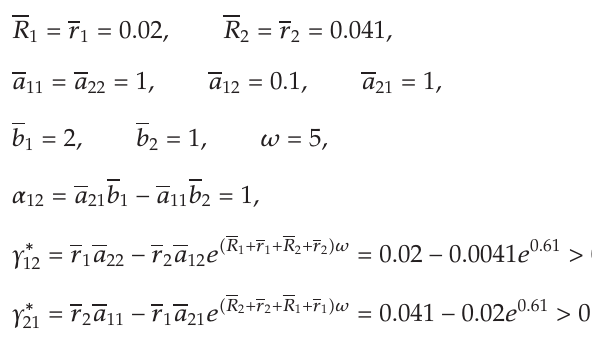
(cid:5) t (cid:6) , x ∗∗ (cid:5) t (cid:6) 2 1